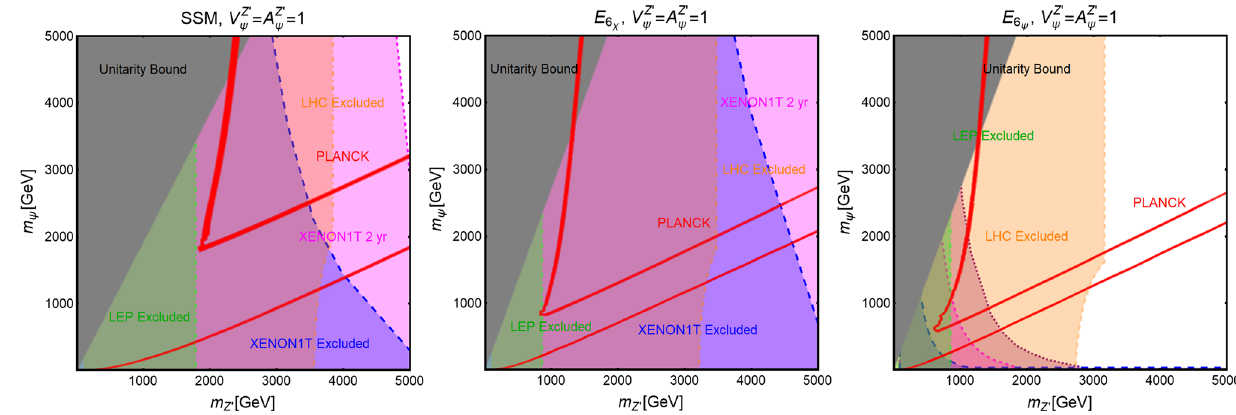
Fig. 13 The same as Fig. 12 but for a Dirac fermion DM in the m Z (cid:15) , m ψ bi-dimensional plane for the choice of V Z (cid:15) ψ = A Z (cid:15) ψ = 1. The new grey region shows exclusion from the unitarity bound